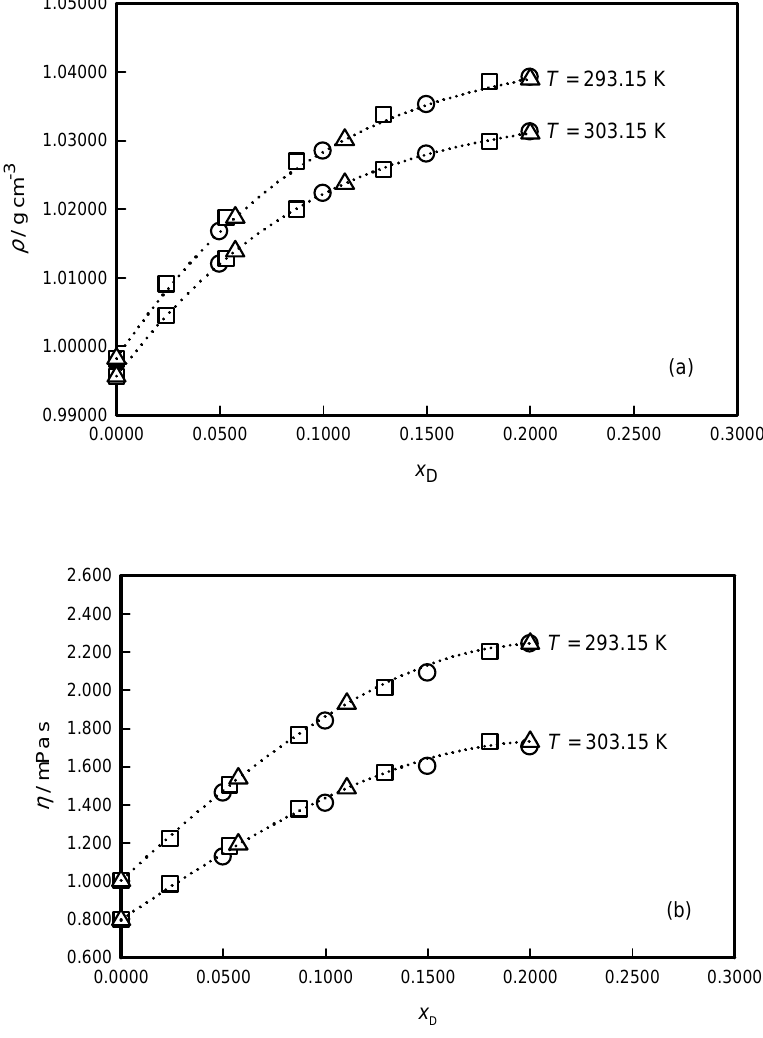
Figure S1. Measured values of density (a), and viscosity (b) of water–1,4-dioxane mixtures at two selected temperatures of 293.15 K and 303.15 K together with the data reported in literature. ○ , this work; D , Ref. 16.; □ , (a) from Ref. 23.; □ , (b) from Ref. 22 in the